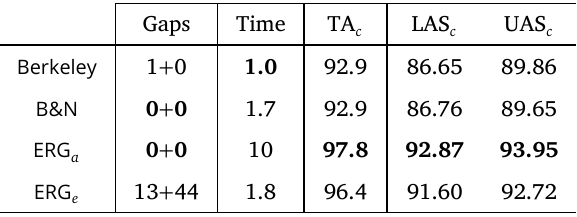
Parse failures and token mismatches